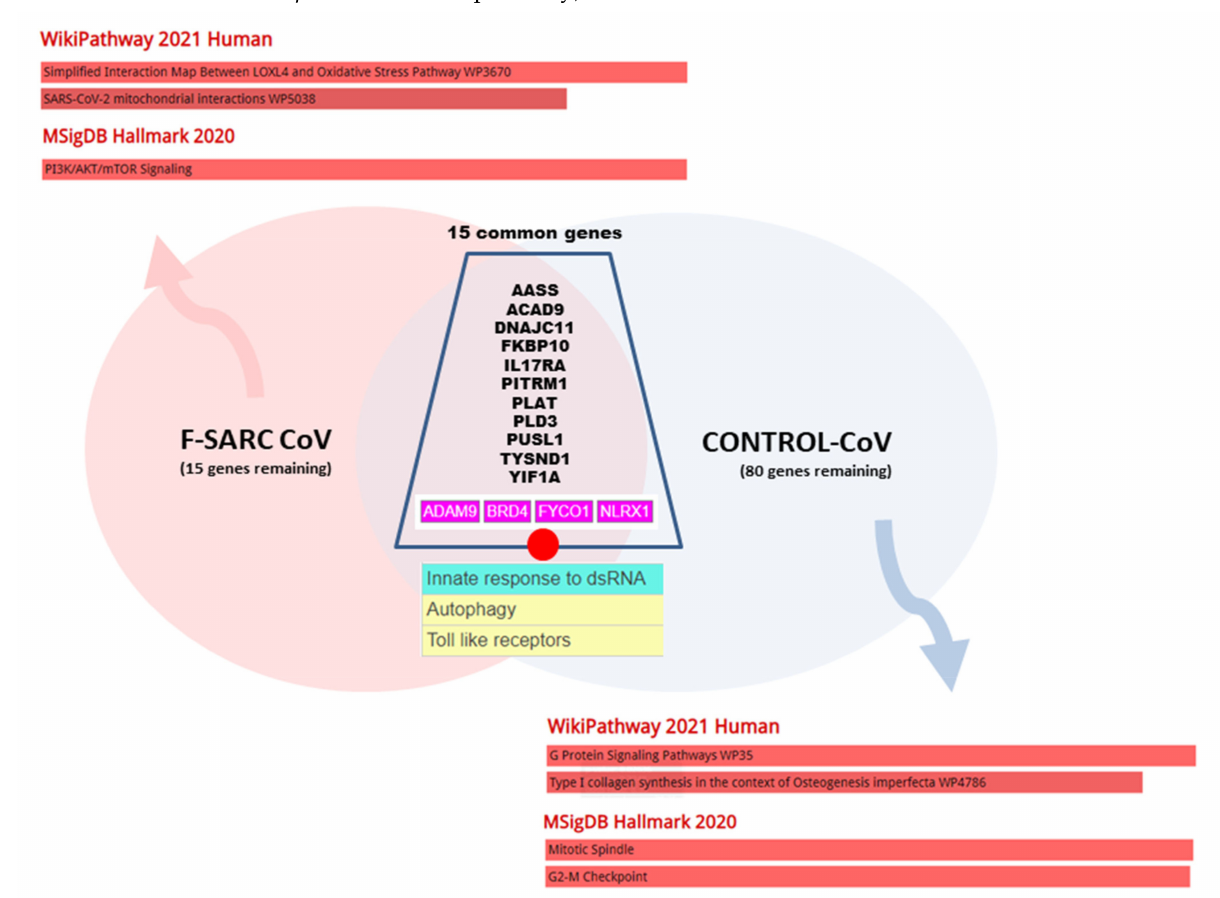
Figure 6. Venn diagram of the clusters of gene sharing pathogenic variants in F-SARC-CoV (sarcoidosis) and control series. Gene acronym descriptions are in the